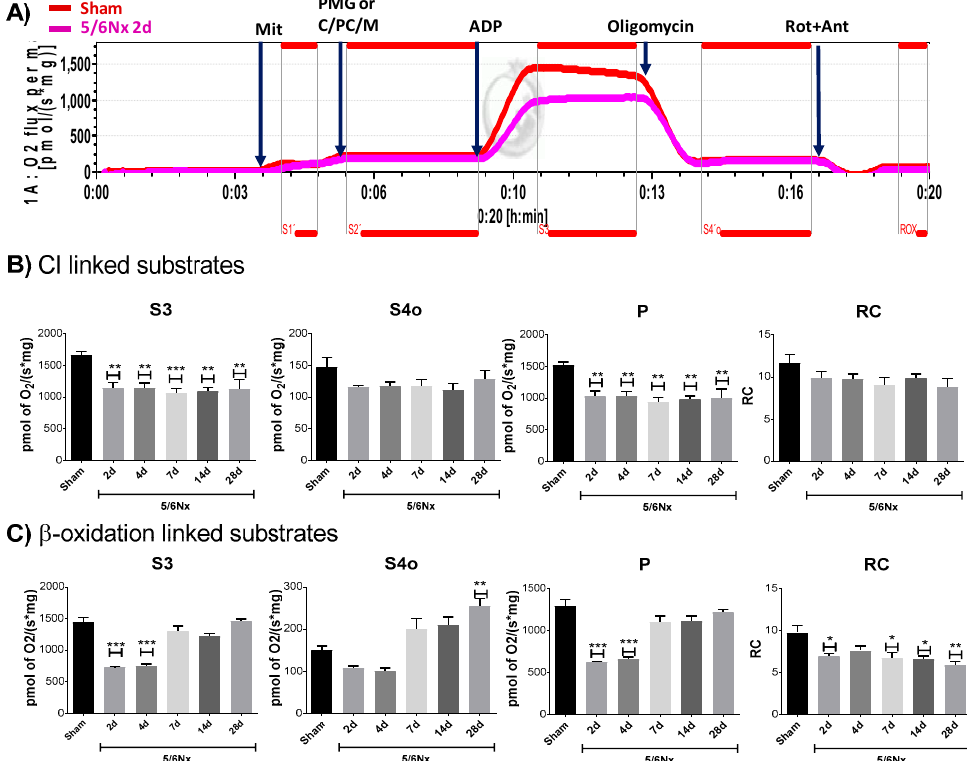
Figure 3. Mitochondrial respiratory parameters in renal remaining mass. ( A ) Schematic representations of the protocol used to determine the respiratory parameters. Red line corresponds to the rate of oxygen (O 2 ) consumption of the Sham group; meanwhile, the purple line corresponds to the rate of O 2 consumption of the nephrectomy group on day 2. Then, 5 mM pyruvate, 2 mM malate, and 10 mM glutamate were used as CI-linked substrates and 2 mM L-carnitine plus 2 µM palmitoyl-L-carnitine plus 2 mM malate (C/PC/M) were used as β -oxidation-linked substrates. Blue arrows represent the additions. ADP = adenosine diphosphate, CI = complex I, L = leak of respiration, Mit = mitochondria, Rot = rotenone, Ant = antimycin A, ROX = residual non-mitochondrial respiration. ( B ) Respiratory parameter of CI-linked respiration: state 3 (S3), state 4 induced by oligomycin (S4o), oxidative phosphorylation (OXPHOS) associated respiration (P), and respiratory control (RC). Data are mean ± SEM, n = 4–6. ** p < 0.01 vs. Sham, Dunnett test. ( C ) Respiratory parameter of β -oxidation-linked respiration: S3, S4o, P, and RC. Data are mean ± SEM, n = 4–6. * p < 0.05, ** p < 0.01, and *** p < 0.001 vs. Sham, Dunnett test. d = days after nephrectomy surgery, Sham = simulated operation-control group, 5/6Nx= 5/6 nephrectomy.